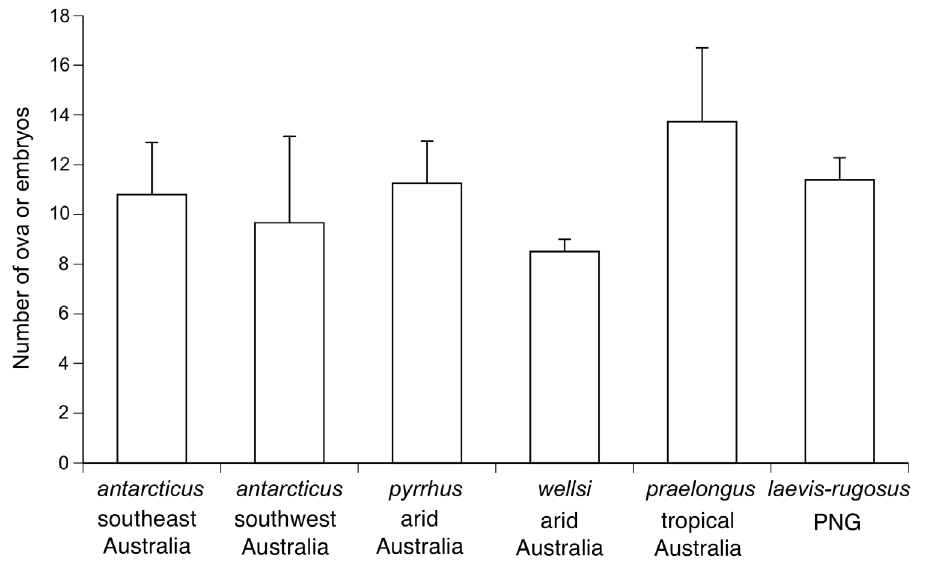
Figure 4. Interspecific variation in mean litter sizes of death adders (genus Acanthophis ). Graph shows mean values and associated standard errors.